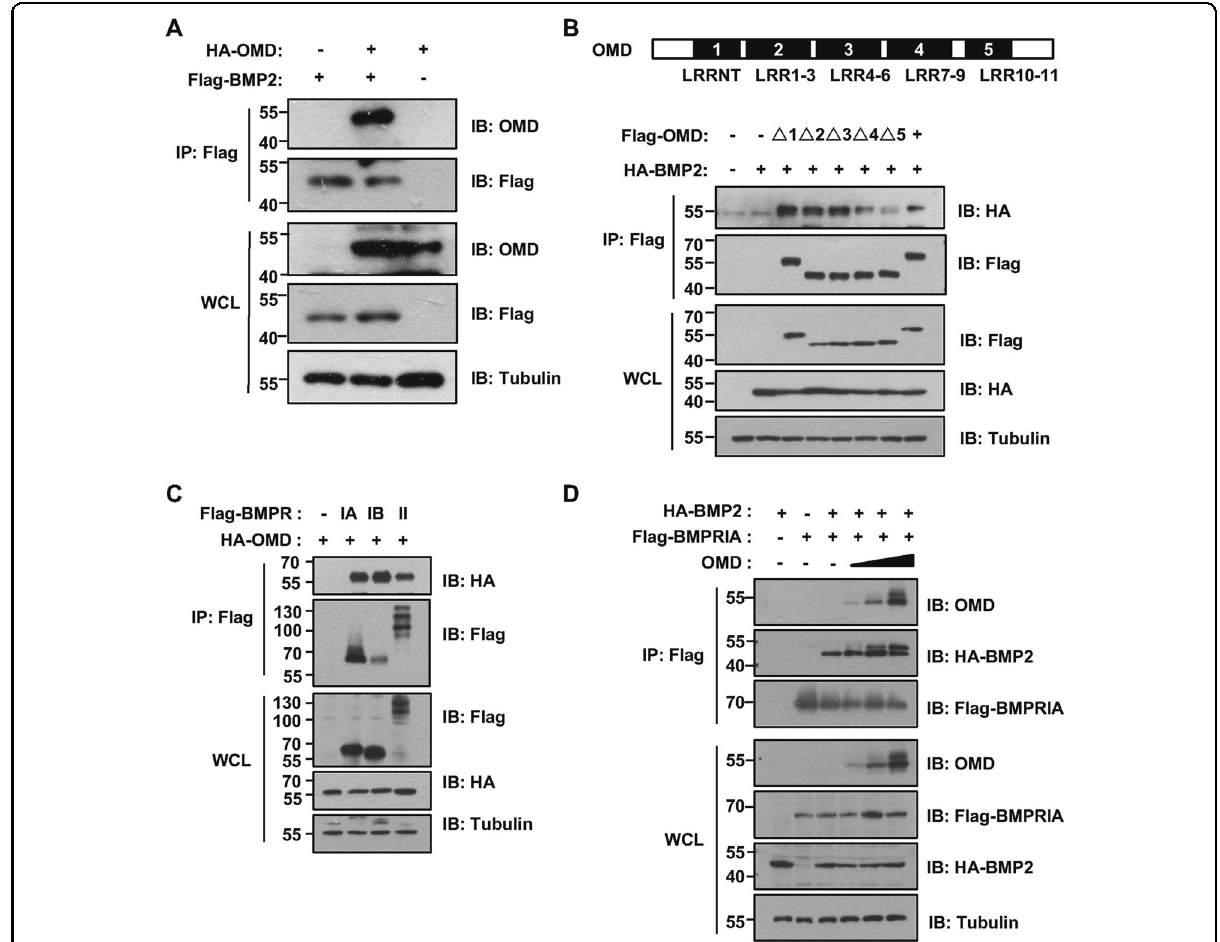
Fig. 3 The interaction among OMD, BMP2, and BMP cell surface receptors. A The interaction of OMD and BMP2 was detected at exogenous level in 293 T cells by immunoprecipitation (IP). Immunoblot (IB) analysis of whole-cell lysates (WCL) with indicated antibodies was shown. B Immunoblot analysis of WCL and IP of 293T cells transfected with HA-BMP2 and different Flag-OMD truncates. C Flag-IP and IB analysis of 293T cells transfected with Flag-BMP receptors and HA-OMD plasmids. D 293T cells were transfected with OMD, Flag-BMPRIA and HA-BMP2 constructs as indicated and cell lysates were harvested for IP and IB